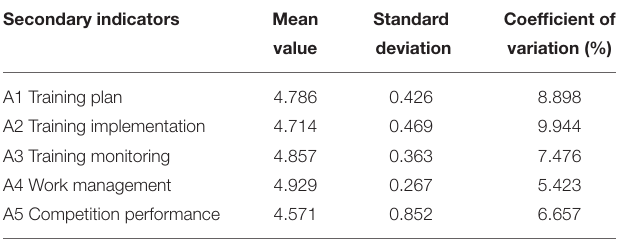
TABLE 10 | Survey results of first-level index experts.